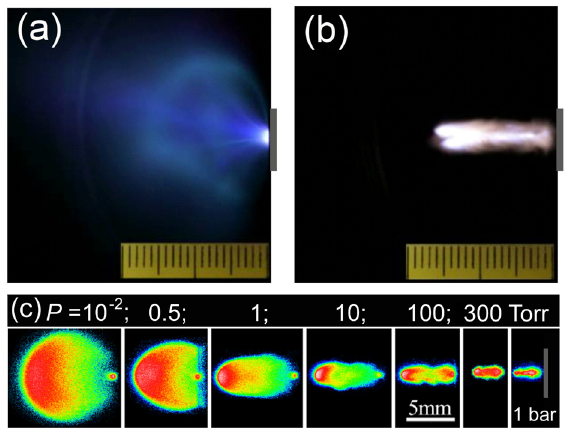
Figure 1. Spectrally and temporally integrated images of plasma formed upon CO 2 -laser ablation of polyimide in air at ( a ) 10 − 2 Torr and ( b ) 760 Torr [14]. Laser pulse comes from the left. Target location is marked by grey bars. Scale division is 1 mm. Laser fluence F 0 = 50 J/cm 2 , total pulse duration ~4 μs. ( c ) Spectrally integrated images of ultrafast laser ablation of copper in air at different pressures at 1.2 μs after irradiation (adapted from [15]). Irradiation conditions for ( c ): laser wavelength 800 nm; pulse duration 40 fs; loose focusing ( f = 40 cm); spot size 300 μm; pulse energy 4.5 mJ that would correspond 3.5 × 10 14 W/cm